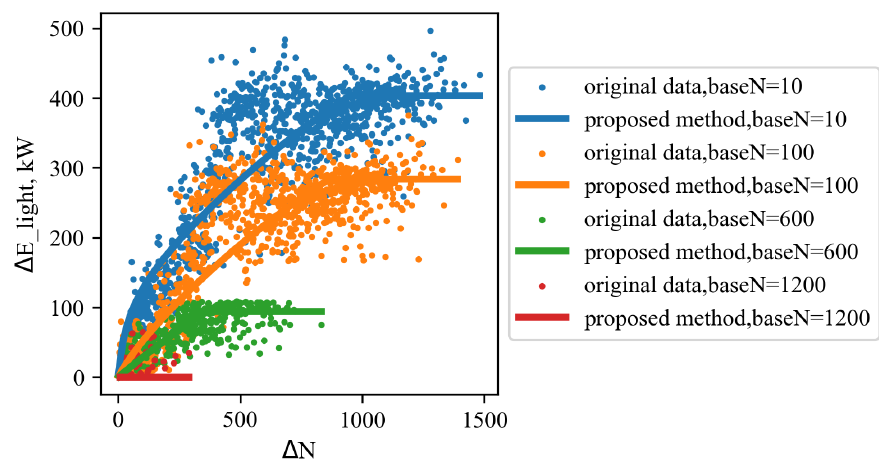
Figure 13. Comparison of ∆E light calculated by the proposed method and actual data.